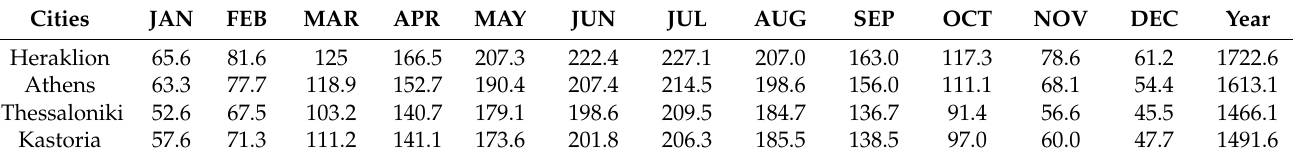
Table 3. Data for the daily global solar irradiation on the horizontal surface (H) in [kWh/m 2